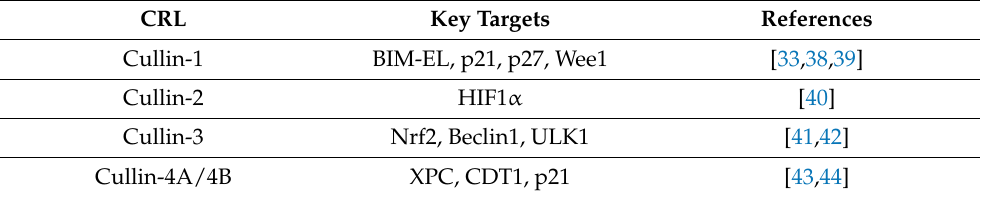
Table 1. Cullin-RING Ligases and Selected Targets.